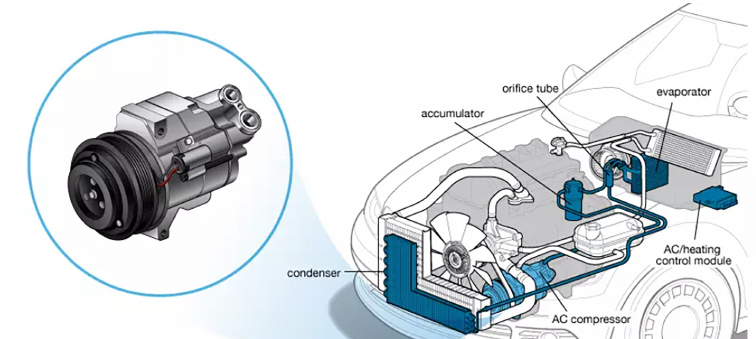
Figure 4. The investigated compressor and its location within the topology of an air-conditioning system of a car.